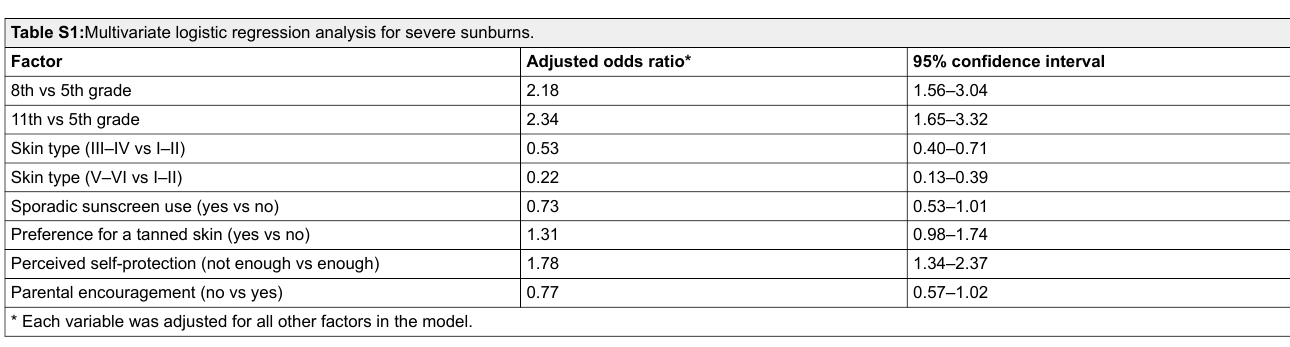
Table S1: Multivariate logistic regression analysis for severe sunburns.